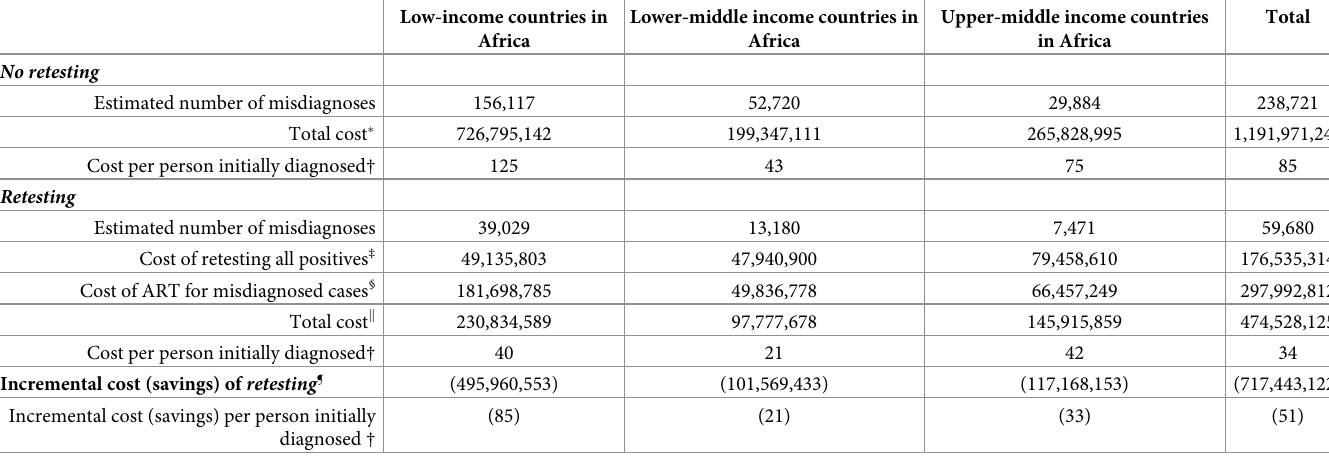
Table 4. Costs under retesting and no retesting scenarios, over ten-year time horizon (2017